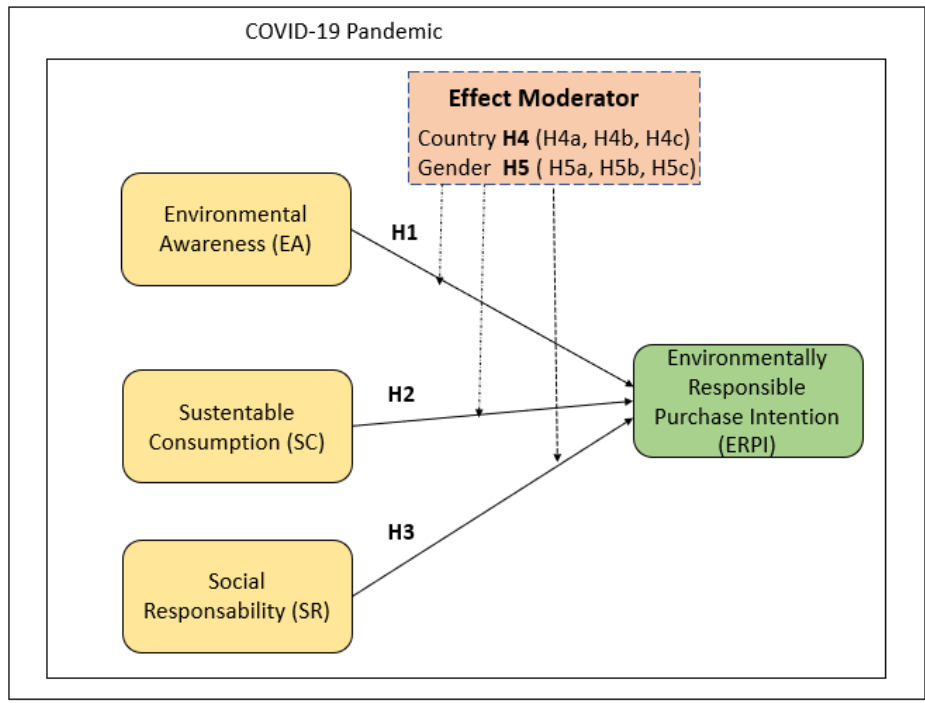
Figure 1. Framework and integrated